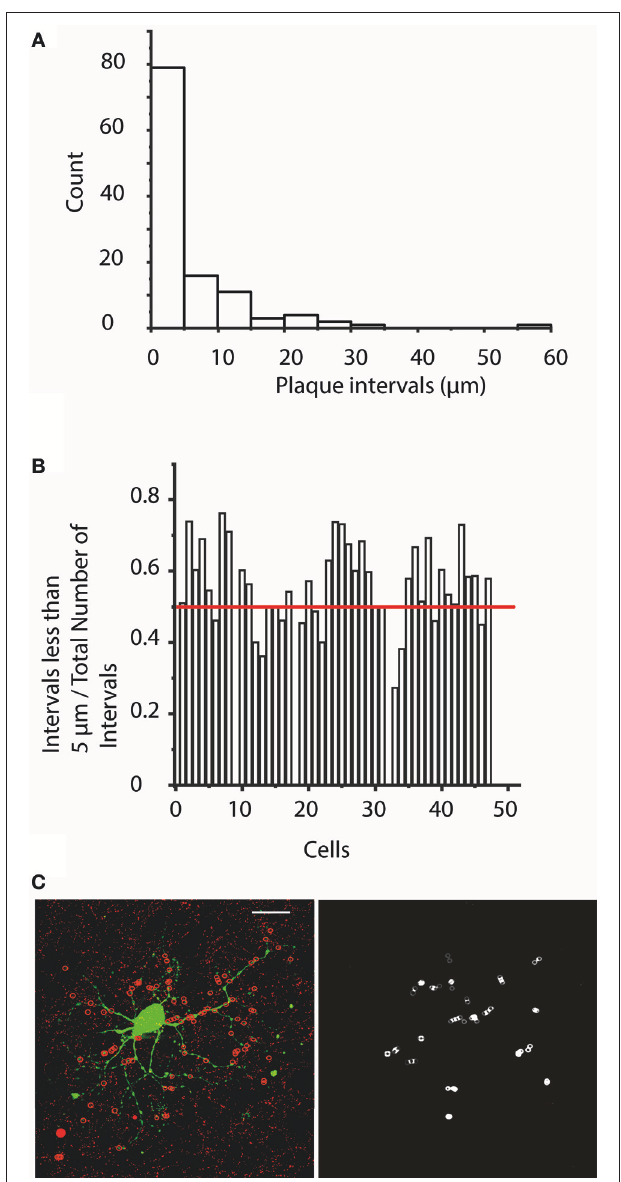
FIGURE 6 | Cx36 plaques tend to form clusters. (A) Bar histogram shows the results of “plaque interval” measurements (bin size 5 µ m) for one representative hRGC. This analysis provides distance values measured between each plaque and its direct proximal neighbor. It is clear that plaque distances < / 5 µ m occur most often indicating that Cx36 plaques of this = neuron have a tendency to cluster into doublets or perhaps even triplets. (B) This histogram displays the ratio of the number of < 5 µ m intervals and the total number of intervals for all hRGCs of this study. This analysis indicates that 33 cells display ratios > 0.5, suggesting that the majority of the plaques for these 33 cells form pairs/clusters. Note, that very small cells with only one plaque per segment have no plaque intervals, hence on this chart they show up with a value of 0. (C) Image on the left displays a representative hRGC and Cx36 labels. Colocalizing plaques were marked with red circles overlaid on dendrites for better visibility (red circles mark only colocalized Cx36 plaques that were confirmed in Neurolucida reconstructions). Note that this hRGC is the same as the one shown in Figure 1 . The image to the right display circles that mark direct neighbor Cx36 plaques in < 5mm apart. Scale bars: 25 µ